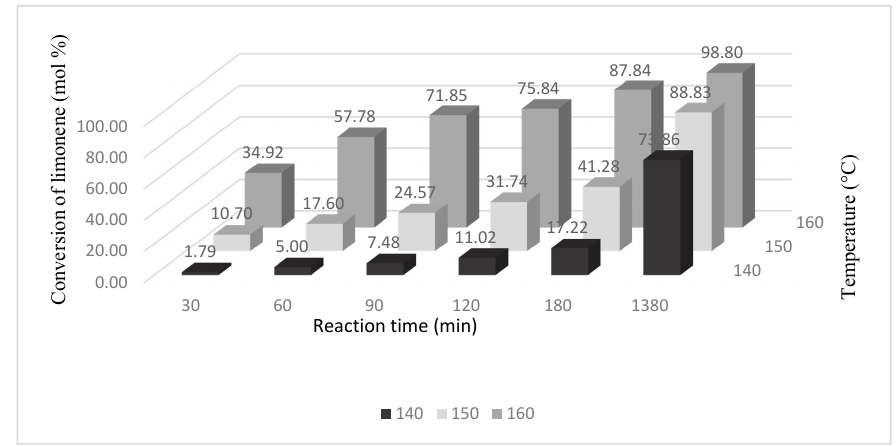
Figure 4. Influence of temperature and reaction time on the conversion of limonene. Amount of the catalyst was 0.75 g (15 wt % in relation to the mass of limonene), the temperature was 140, 150, or 160 ◦ C, and the reaction time was 30, 60, 90, 120, 180, or 1380